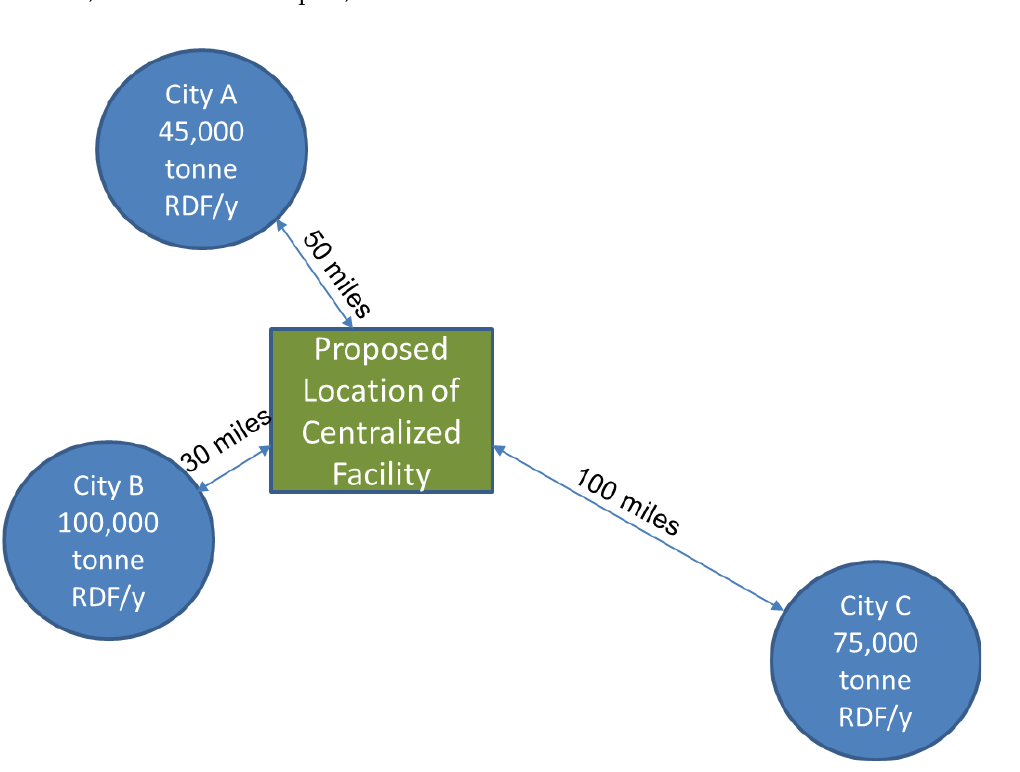
Figure 3. Biomass availability and relative locations for the case study.